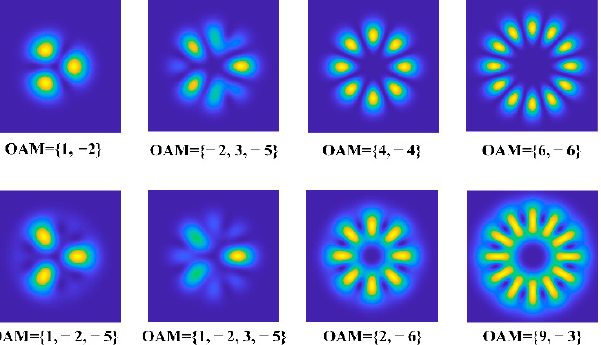
Figure 5. Light intensity distribution of a similar multi-mode OAM beam.